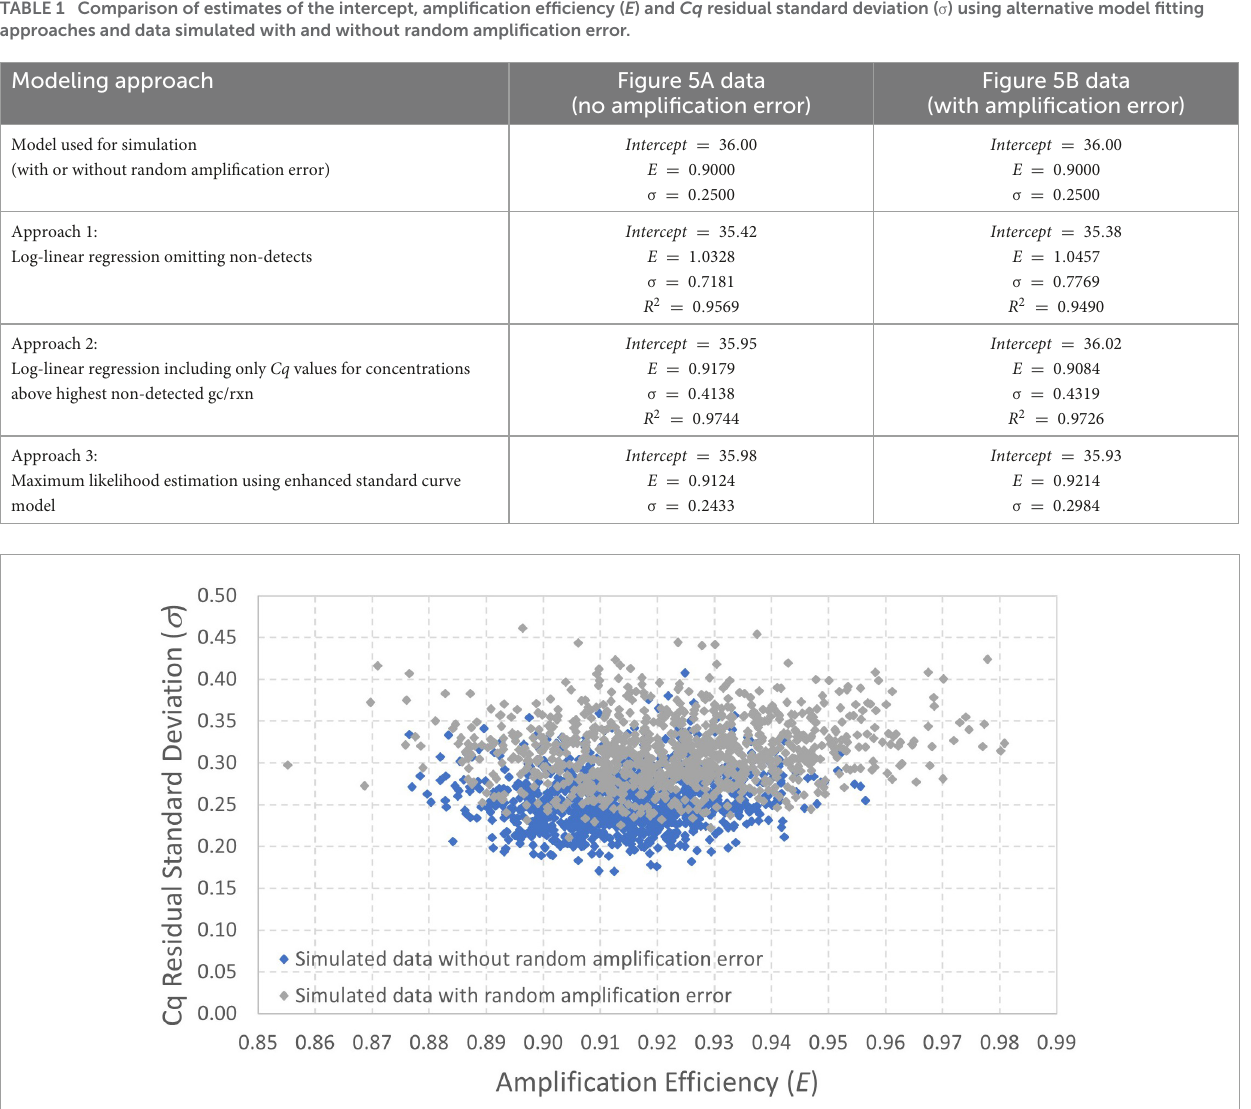
TABLE 1 Comparison of estimates of the intercept, amplification efficiency ( E ) and Cq residual standard deviation ( σ ) using alternative model fitting approaches and data simulated with and without random amplification error. Modeling approach Figure 5A data